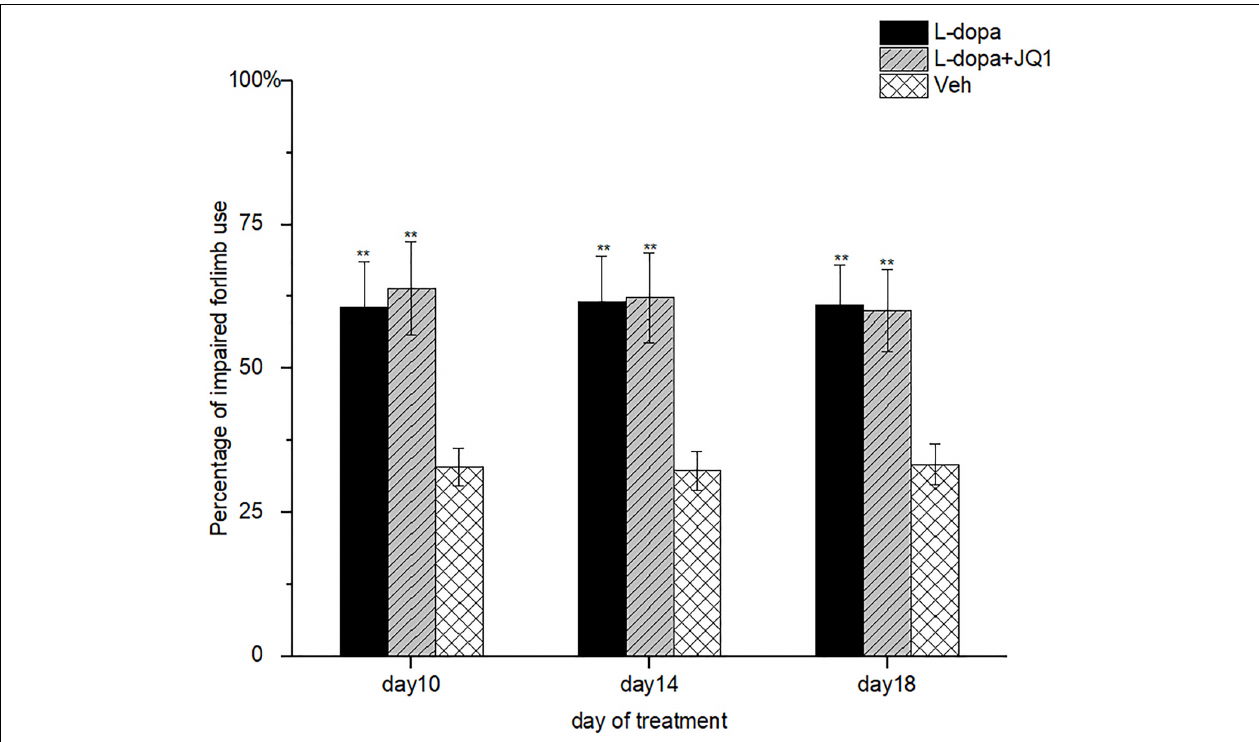
FIGURE 3 | Motor improvement of 6-OHDA-lesioned rat models of PD treated with L-dopa (L-dopa, 12 mg kg − 1 , bensarazide, 6 mg kg − 1 , i.p., once a day) (L-dopa treatment group, n = 18), L-dopa (L-dopa, 12 mg kg − 1 , bensarazide, 6 mg kg − 1 , i.p., once a day) plus JQ1 (25 mg kg − 1 , i.p., once a day) (L-dopa + JQ1 treatment group, n = 18), or Veh ( n = 6) was assessed by cylinder tests on days 10, 14, and 18 of the treatment. At each assessment, both the L-dopa group and the L-dopa + JQ1 group showed a better performance as the treated 6-OHA-lesioned PD rats preferred to touch the inner wall of the cylinder with the impaired forelimbs more frequently ( p < 0.001 vs. Veh group). Meanwhile, no difference was found in the rats’ preference in touching the inner wall with the impaired forelimbs in cylinder tests between the L-dopa and L-dopa + JQ1 treatment groups ( p > 0.05). Data are presented as mean ± SD; ** p < 0.001 vs. Veh